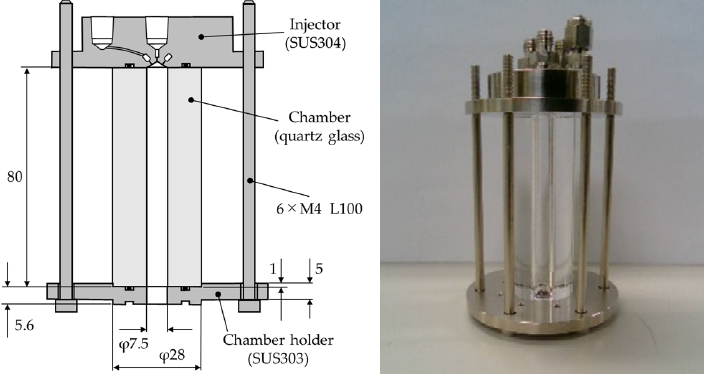
Figure 7. Injector and quartz chamber (left: schematic drawing, right: external view).